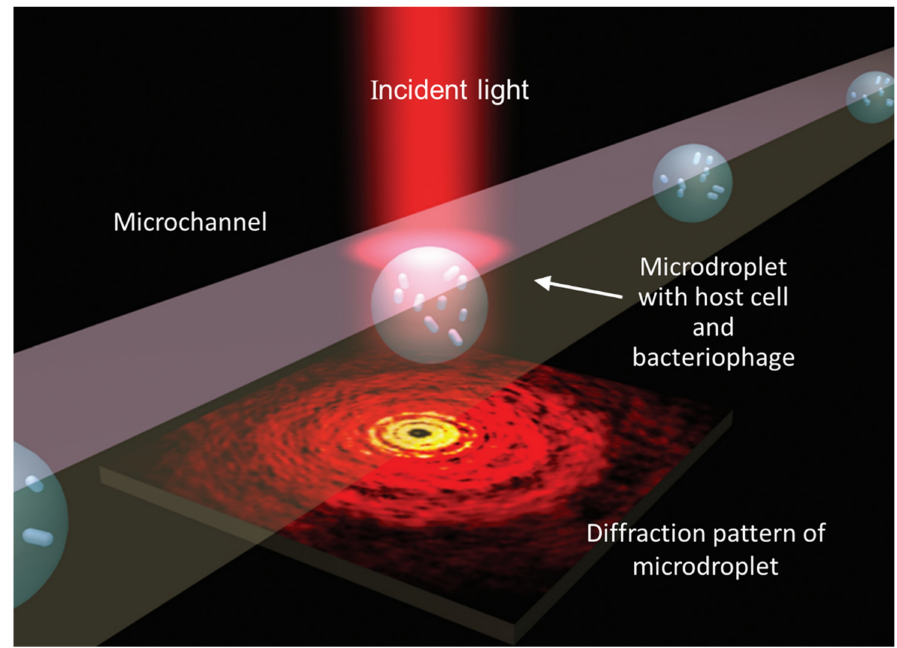
Figure 5. Schematic diagram of the optofluidic imaging based on microdroplets, co-cultured bacteriophage, and host cells ( E. coli )